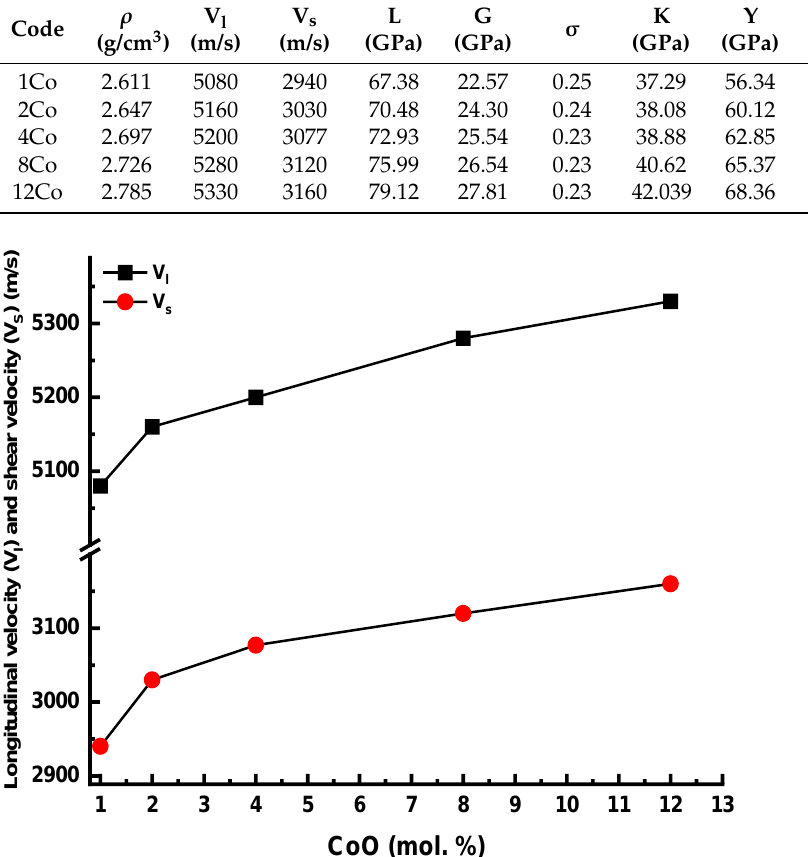
Figure 6. Longitudinal velocity (V l ) and shear velocity (Vs) against glass composition.